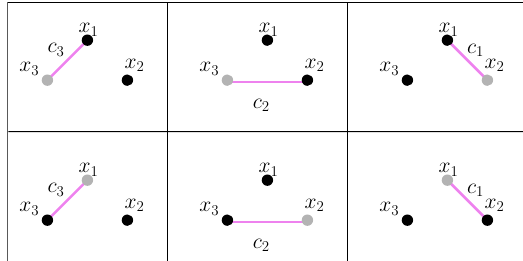
Figure 8: The collection of 2 -rooted forests for K 3